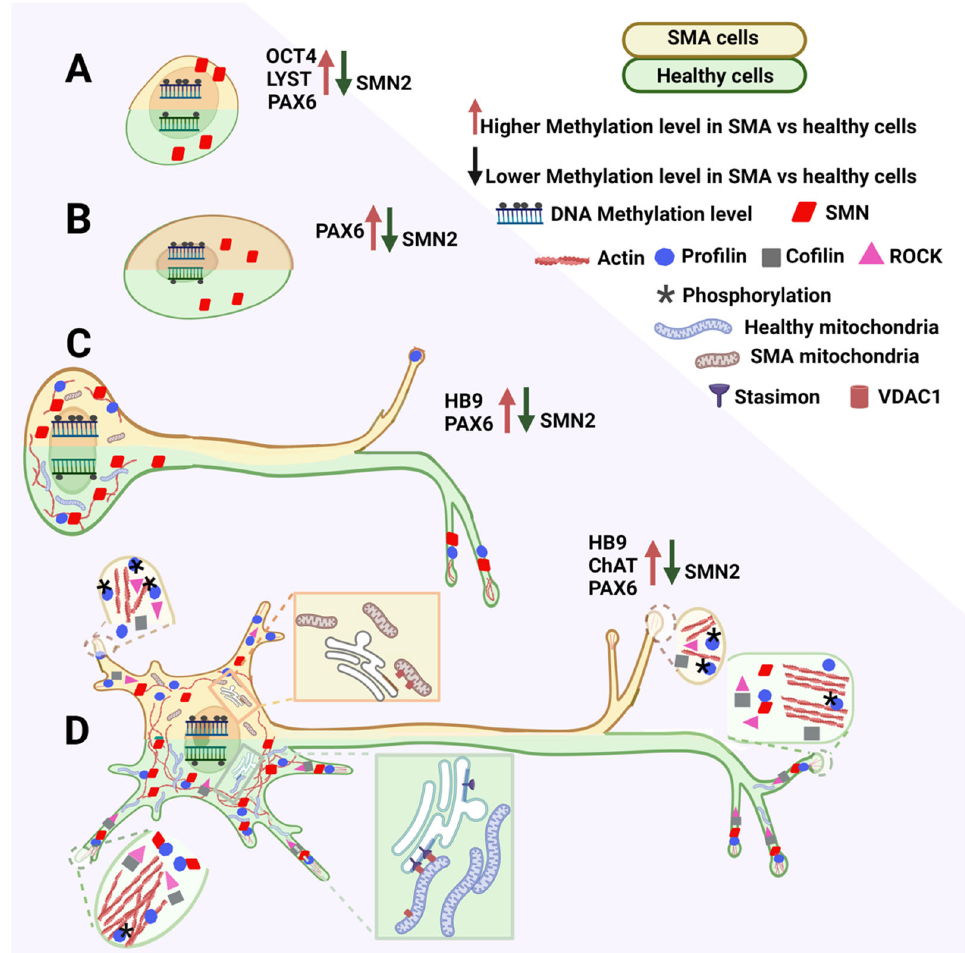
Figure 2. Scheme describing altered interactions in spinal muscular atrophy (SMA) cells during MN development. Each cell drawing is divided in two: the green-shaded half represents cells from healthy individuals, while the orange-shaded half represents cells from SMA patients. Reduced SMA2 methylation is accompanied by an increase in the methylation of various genes. The low SMN protein level alters different pathways and changes protein interactions either at the soma or neurite level. SMA patient mitochondria do not interact properly with the endoplasmic reticulum and have an inappropriate morphology. ( A ): iPSCs; ( B ): NEPs; ( C ): IMNs; and ( D ): MMNs. OCT4: POU class 5 homeobox 1; LYST: lysosomal trafficking regulator; PAX6: paired box 6; HB9: motor neuron and pancreas homeobox 1 gene; and CHAT: Choline